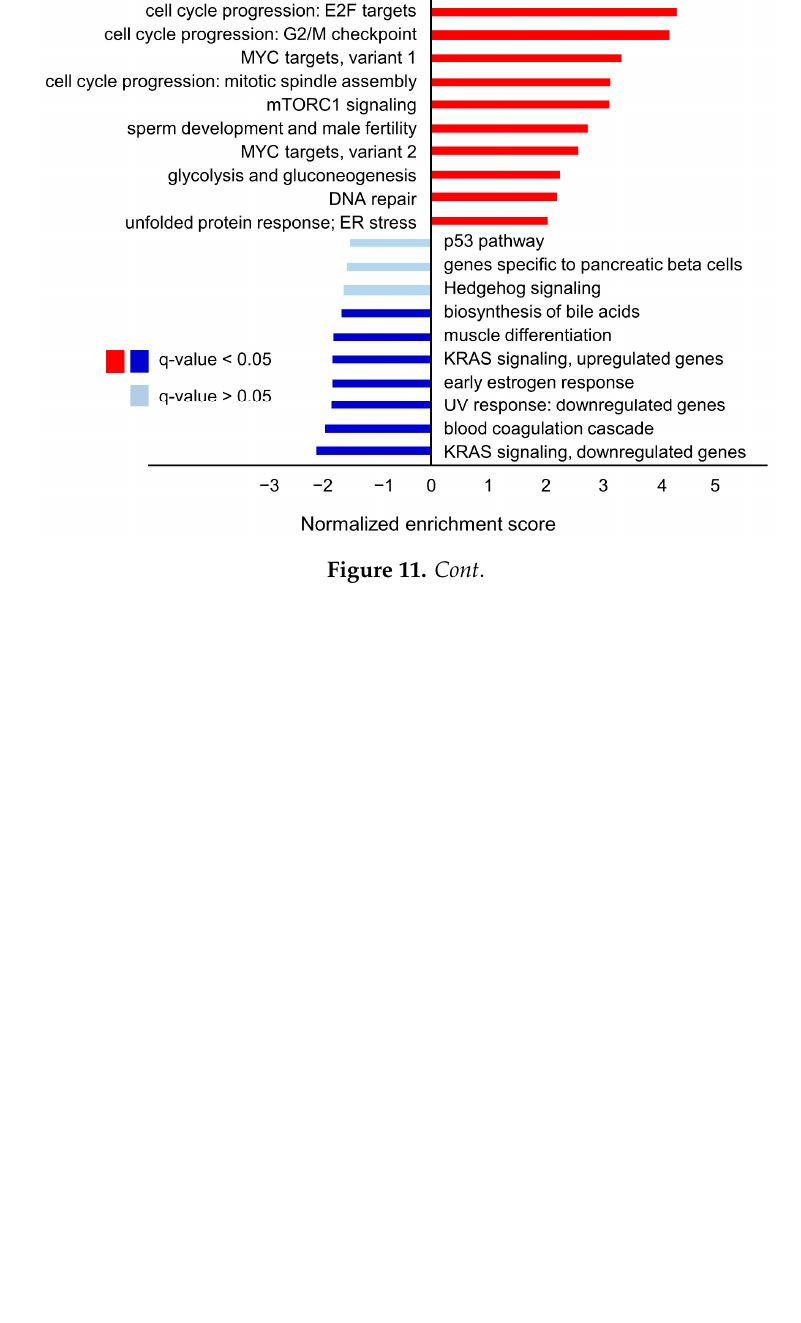
Figure 10. Effect of FAM64A knockdown on cell proliferation and cell cycle arrest in LUAD cells. ( A )